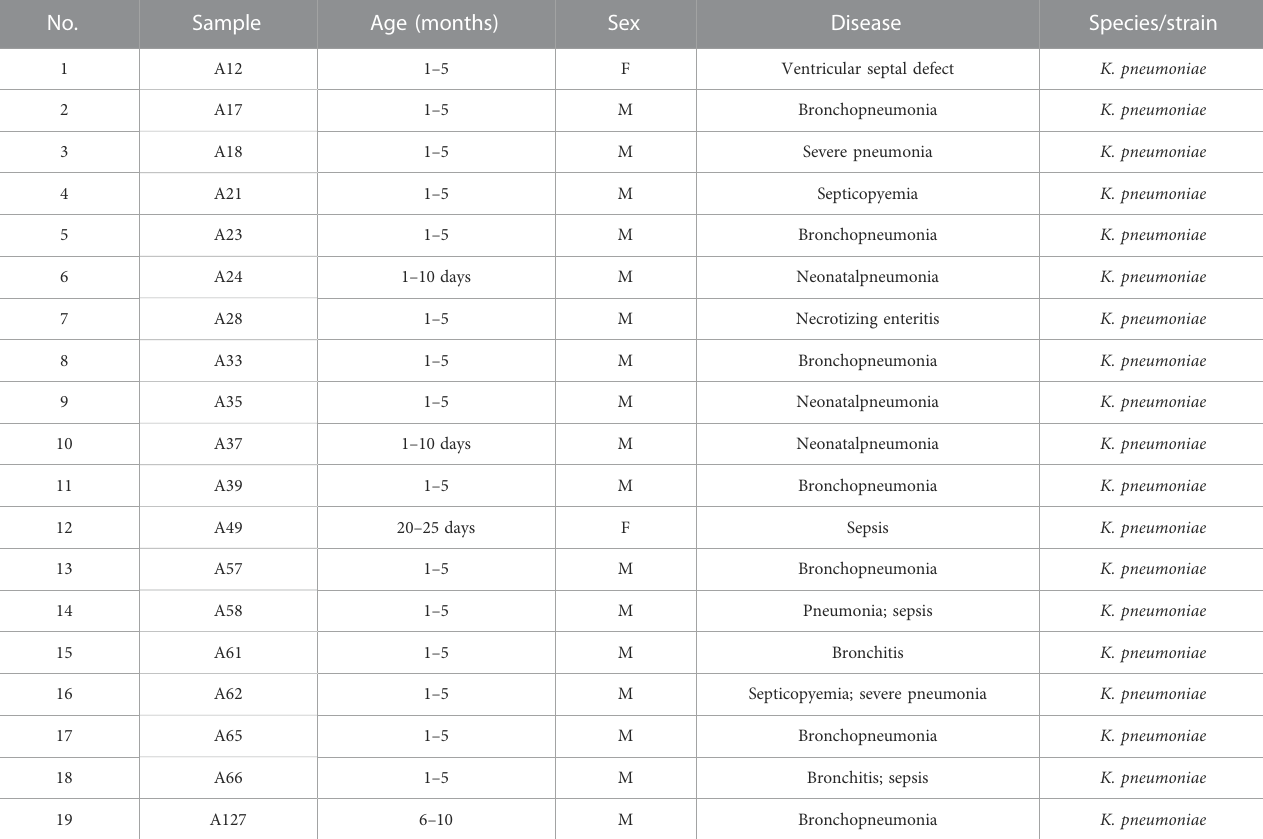
TABLE 1 Bacterial strains of infants used for SEA-ICTS and PCR-ICTS in this study.